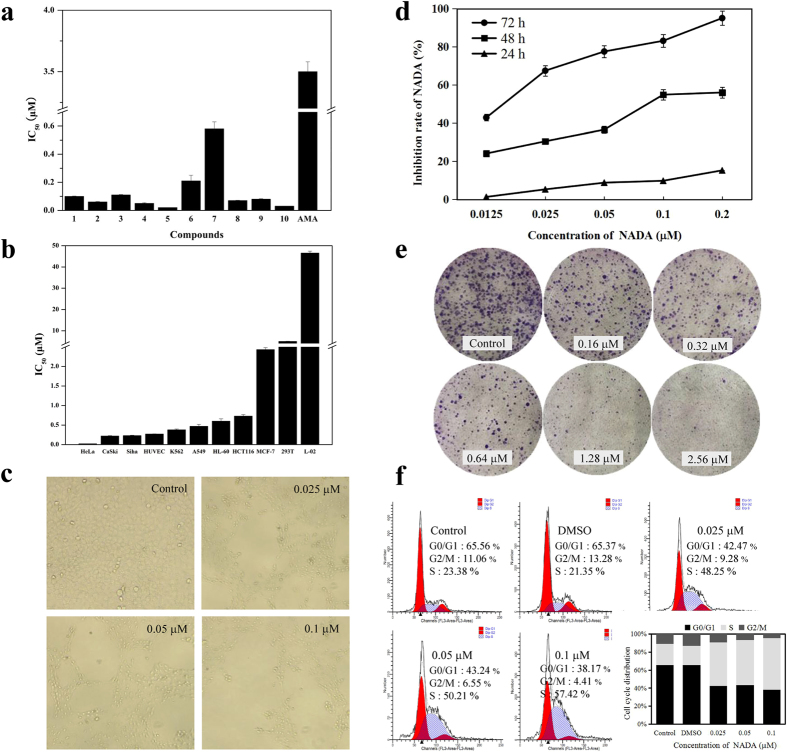
Cytotoxicity of compound 1–10 and the effect of NADA on HeLa cells.(a) The cytotoxicity of 1–10 as well as AMA was evaluated against HeLa cell line. Cells were treated with 1–10 for 72 h, then the cell viability were assayed by 3-(4, 5-dimethylthiazol-2-yl)-2, 5-diphenyltetrazolium bromide (MTT) methods. (b) NADA displayed selective cytotoxicity against HPV-positive cell lines. The selected cell lines were treated with different concentrations of NADA for 72 h, and the cell viability were assayed by MTT methods. (c) Representative pictures showing the effect on cell density of 0, 0.025, 0.05, and 0.1 μM NADA, after incubation for 72 h. (d) NADA inhibited proliferation of HeLa cells time- and concentration- dependently, assayed by MTT method. (e) Results of colony-formation assays of HeLa cells after NADA (0–2.56 μM) treatment for 12 days, with Giemsa staining. (f) NADA induced S phase arrest in HeLa cells. Histogram shows the percentage of cells in G0/G1, G2/M, and S phase, after treated with NADA. All experiments were performed in three replicates (n = 3).